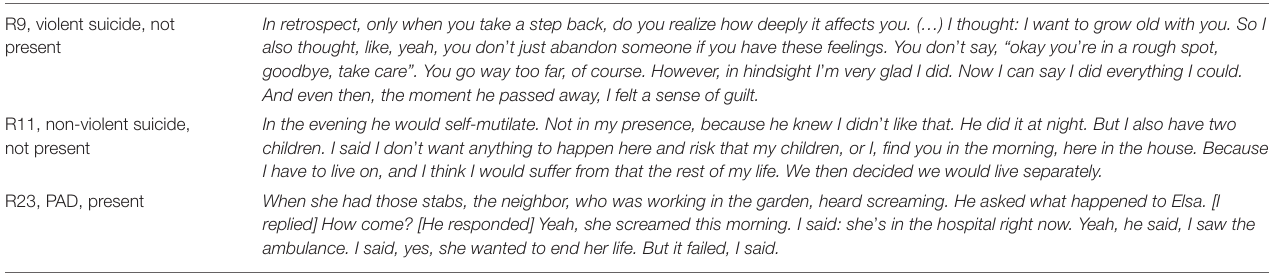
TABLE 3 | Impact of partner’s mental health